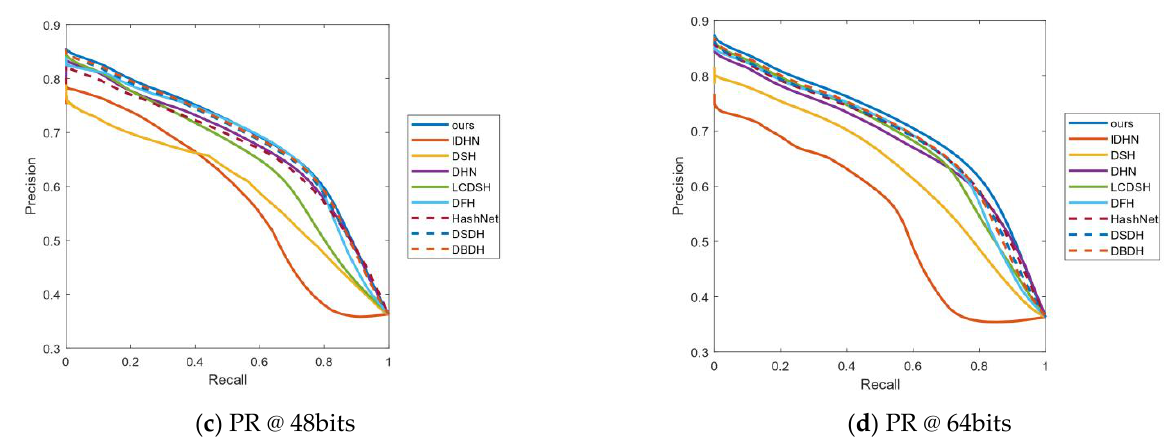
Figure 4. ( a – d ) represent the PR curves on NUS-WIDE of all algorithms when the length of the hash code is 16, 32, 48 and 64 bits, respectively.